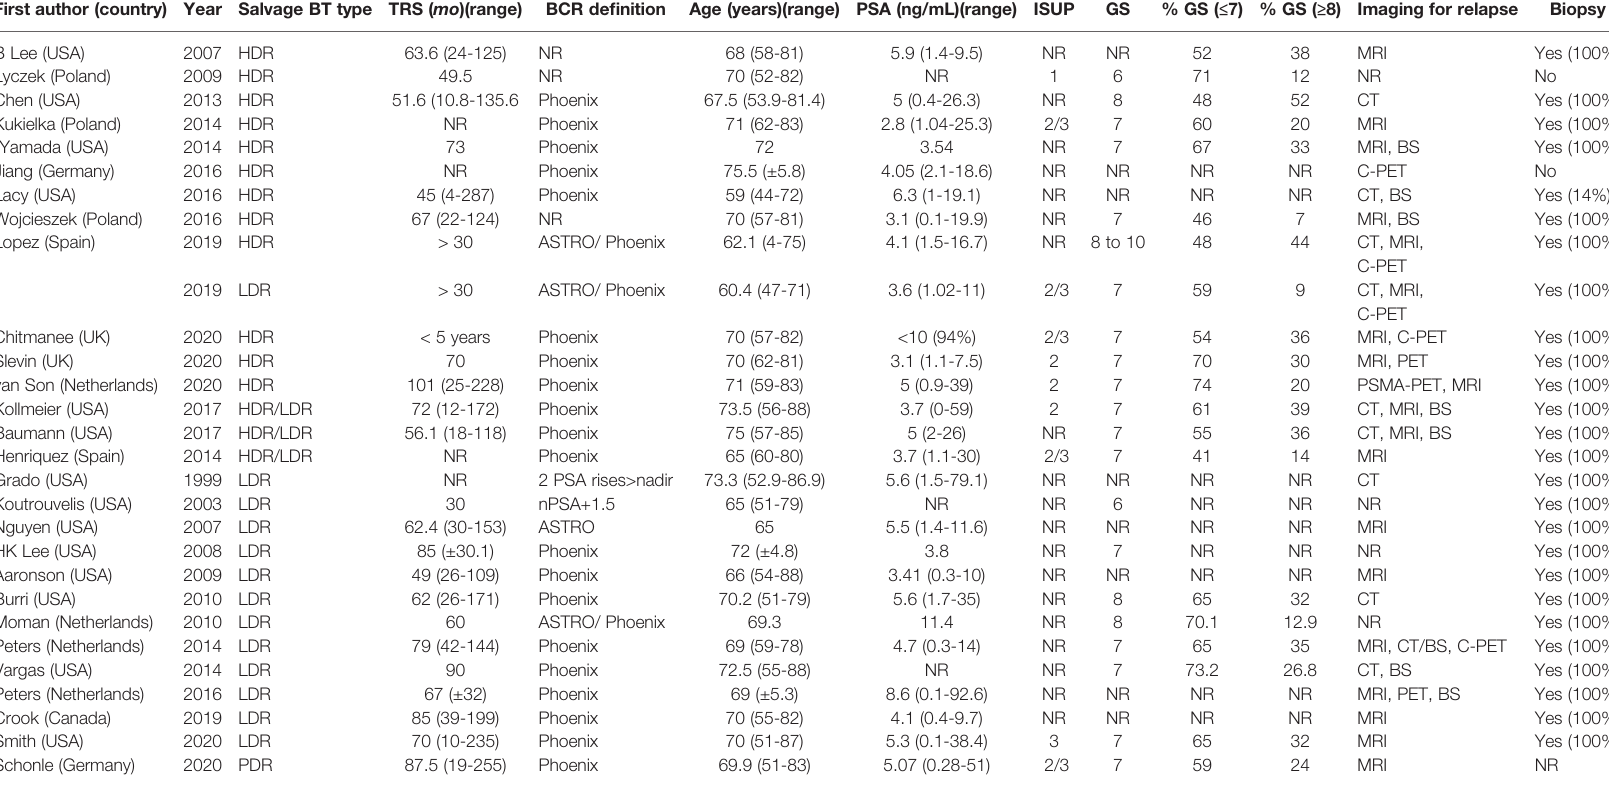
TABLE 3 | Pre-salvage therapy disease and treatment characteristics for brachytherapy